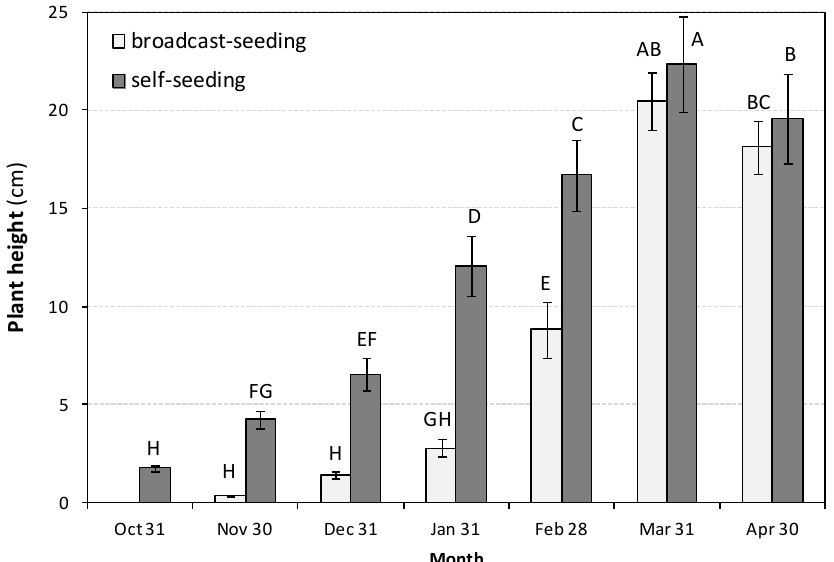
Figure 1. Plan height (cm) of A. arvensis throughout its growth cycle for the two agricultural seasons evaluated, according to the sowing method (mean values). Error bars are standard error of the mean. Di ff erent capital letters indicate significant di ff erences ( p = 0.05) in monthly plant height between both sowing systems according to Fisher LSD tests. Agronomy 2020 , 10 , x FOR PEER REVIEW